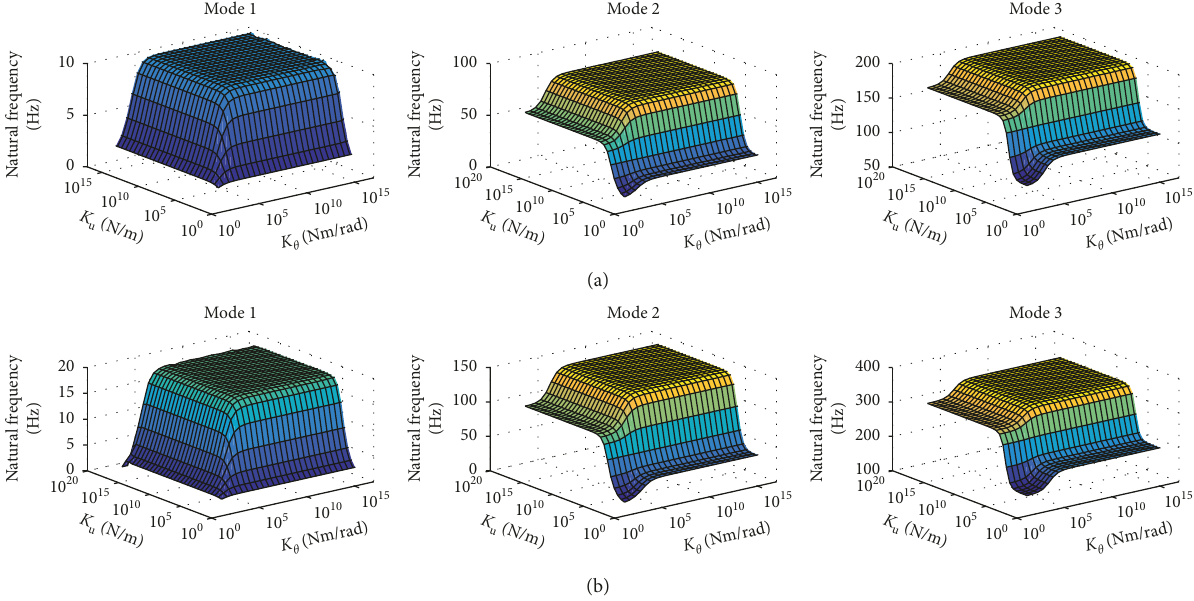
Figure 10: Evolution of the natural frequencies for different Δ K (b) Strong Axis ( X